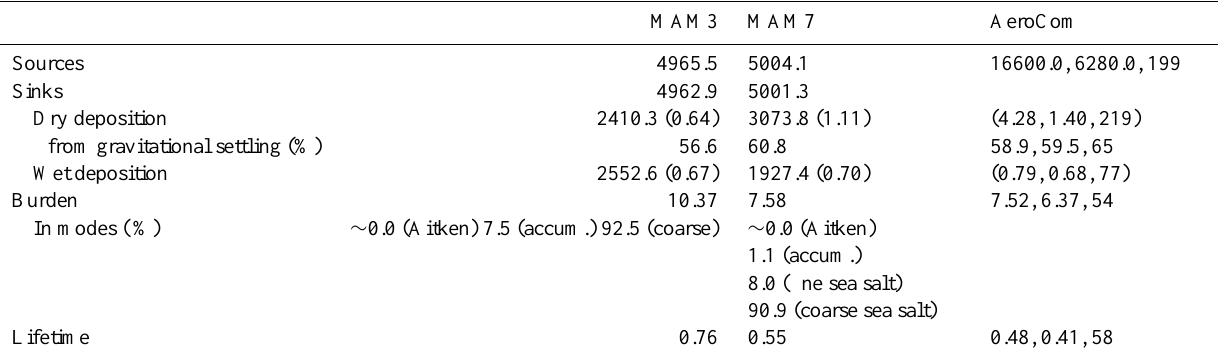
Table 8. Global budgets for sea salt. The means, medians and normalized standard deviations (in %) from available models participating in AeroCom (Textor et al., 2006) are listed. The values in parentheses are mean and median removal rates (in day − 1 ), and normalized standard deviations (in %) as budget terms are not given in Textor et al. (2006). For comparison, removal rates (in day − 1 ) from MAM3 and MAM7 are listed in